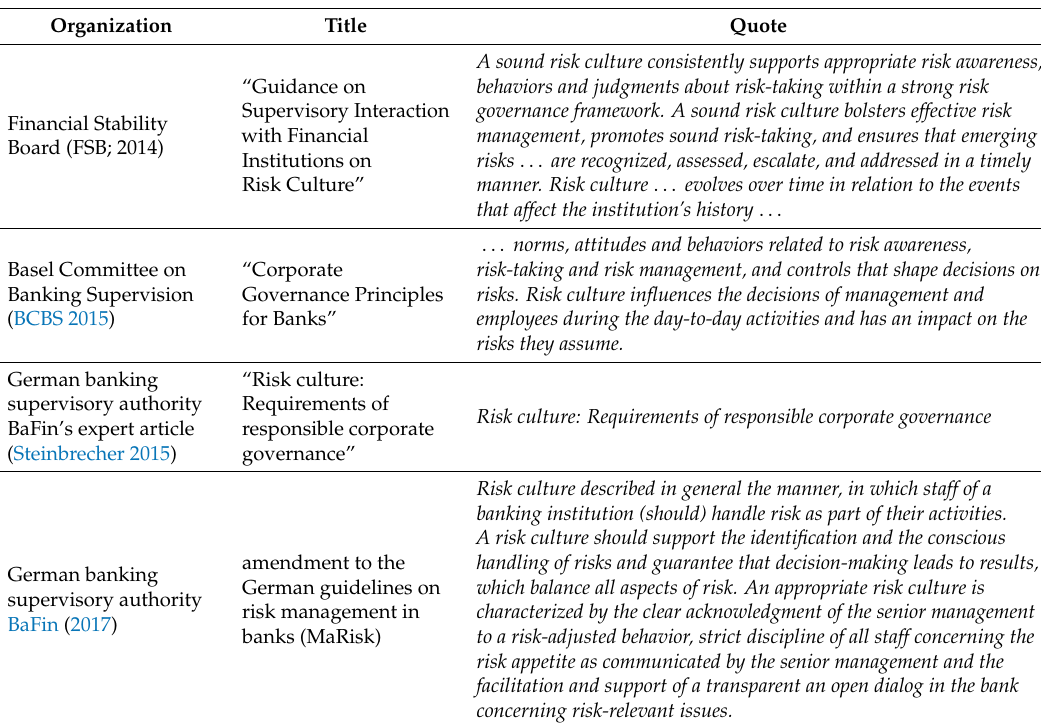
Table 1. Diverging definitions for “Risk Culture” as provided by different regulators or bank supervisors with quotes (emphasis by the authors; see also Milkau 2017). The diverse usage of the term “Risk Culture” indicates the need for a detailed discussion what “Risk Culture” means from the perspective of the different